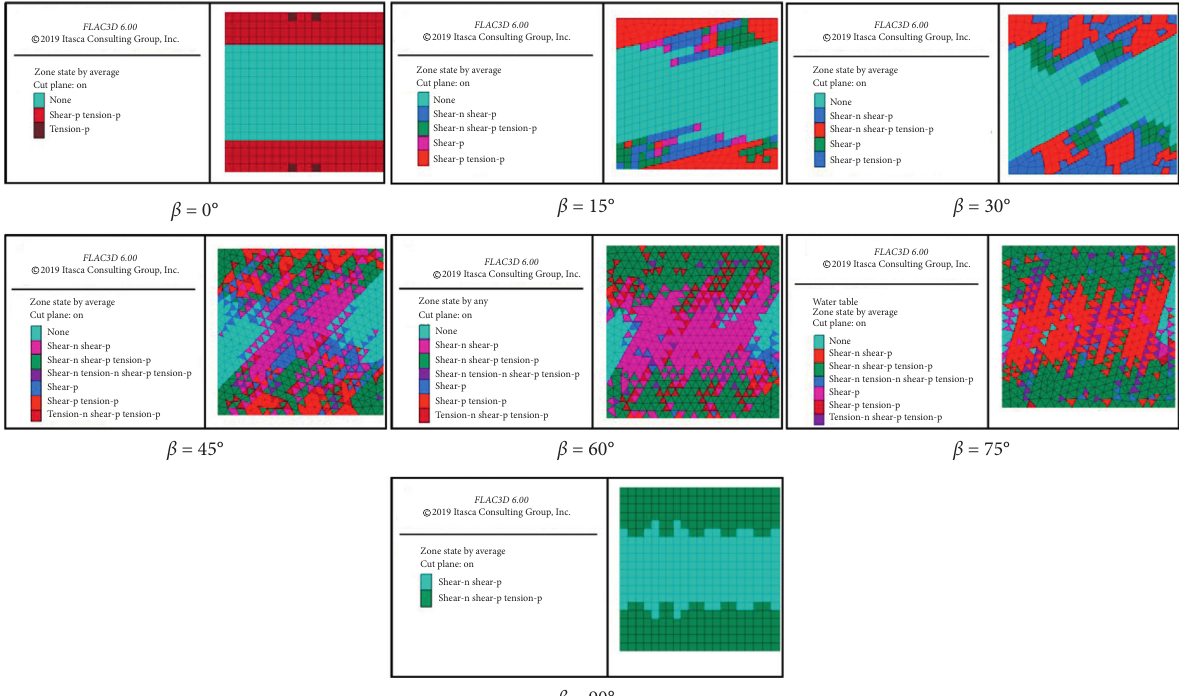
Figure 12: The cutting plane contour of plastically deforming area in CJB with different joint angles calculated by FLAC